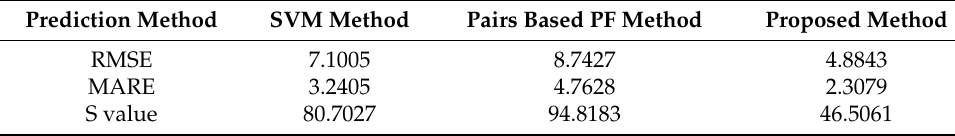
Figure 10. Comparison of prediction error. Table 4. Comparison of prediction